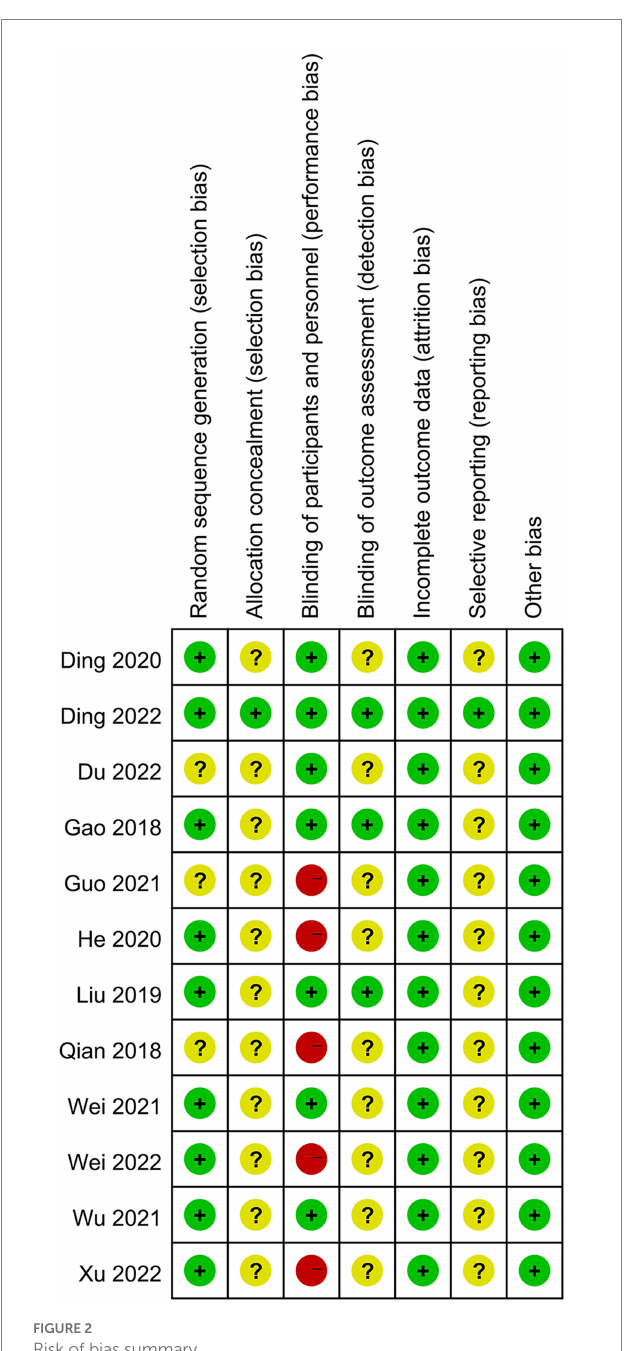
FIGURE 2 Risk of bias